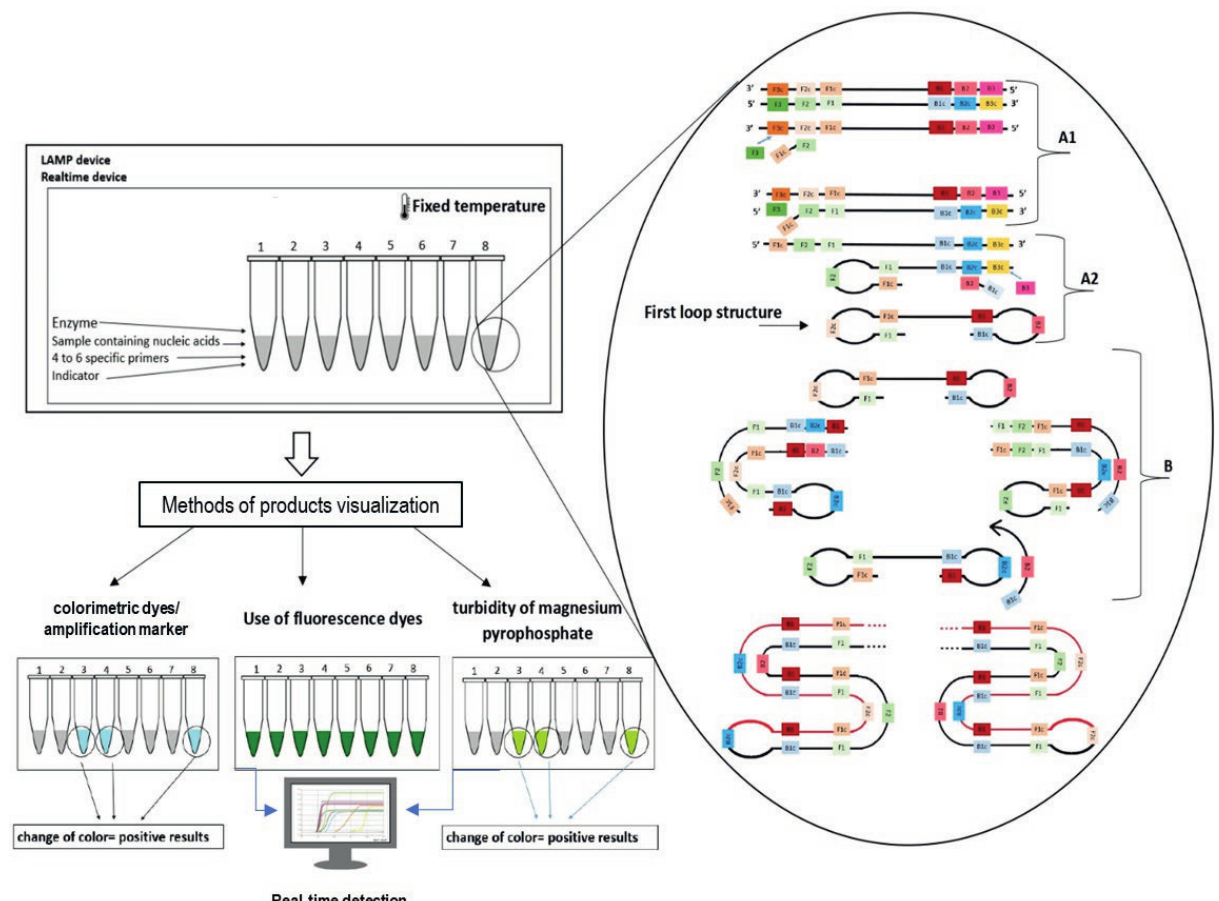
Figure 1. LAMP reaction and amplicon detection. Loop structure production: (A1) annealing and elongation of primer F2 (on primer FIP), followed by annealing and elongation of primer F3 which allows the first strand displacement and first loop formation through the anneal- ing of F1(on primer FIP); and (A2) the annealing of primer B2 (on primer BIP), followed by annealing and elongation of primer B3 with the displacement of the polymerized strand and the formation of the second loop through B1 (on primer BIP). Target amplification (B): repetition of the annealing and elongation cycles on the produced loop and primer